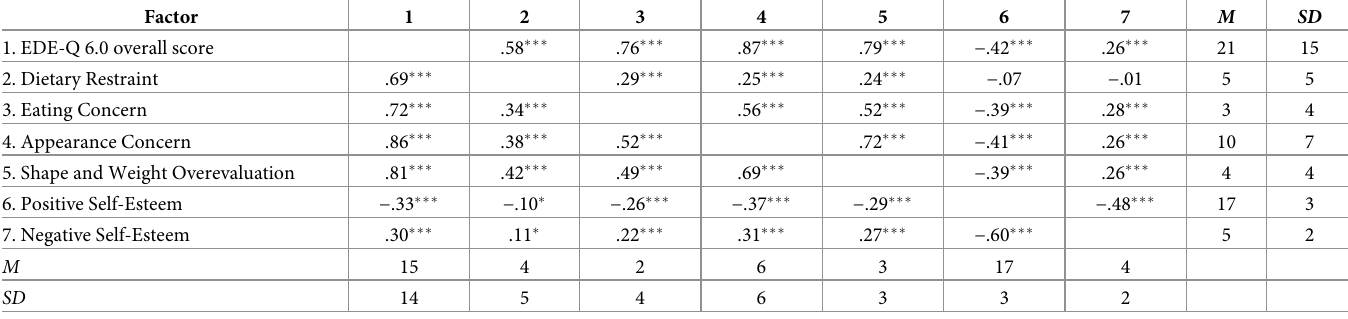
Table 8. Pearson’s correlations among factors of the 14-item eating disorder examination questionnaire 6.0 (EDE-Q 6.0) and the Rosenberg’s self-esteem scale in women ( n = 591) and men ( n = 382).